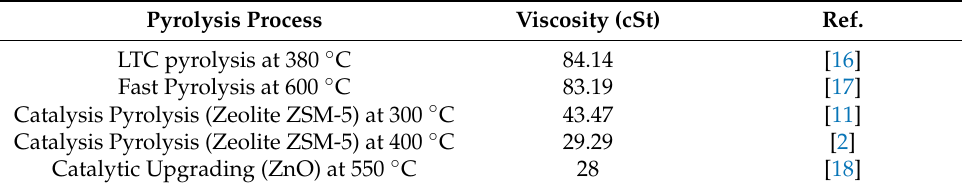
Table 1. Effect of various pyrolysis process on viscosity of castor oil.